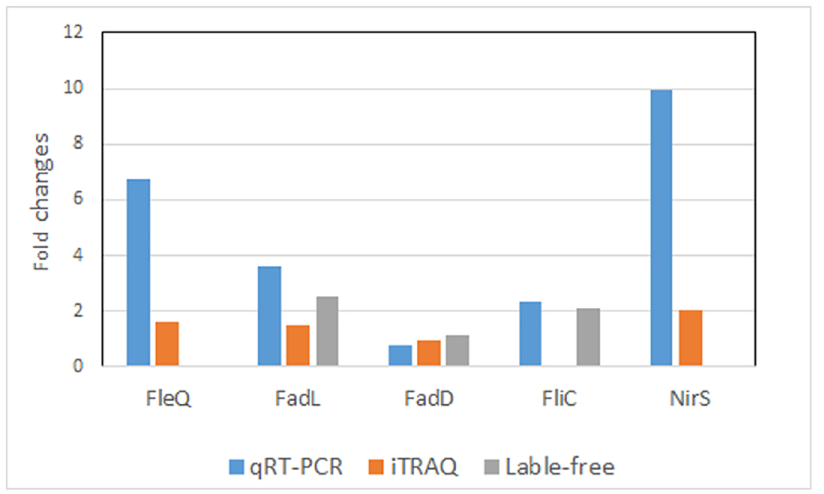
Fig 4. Transcriptional validation of proteomic output using RT-qPCR assays. The value of fold-change in Y-axis indicates the ratio of either protein or mRNA level observedfor strain SJTD-1 growingon C18 as opposedto C16 grown